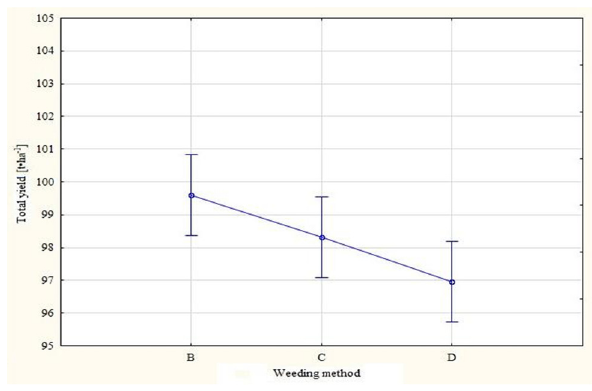
Figure 8: The expected marginal averages for 0.95 con fi dence intervals for the average weight of carrot root in various weeding methods in 2016 ( source: own work ) .